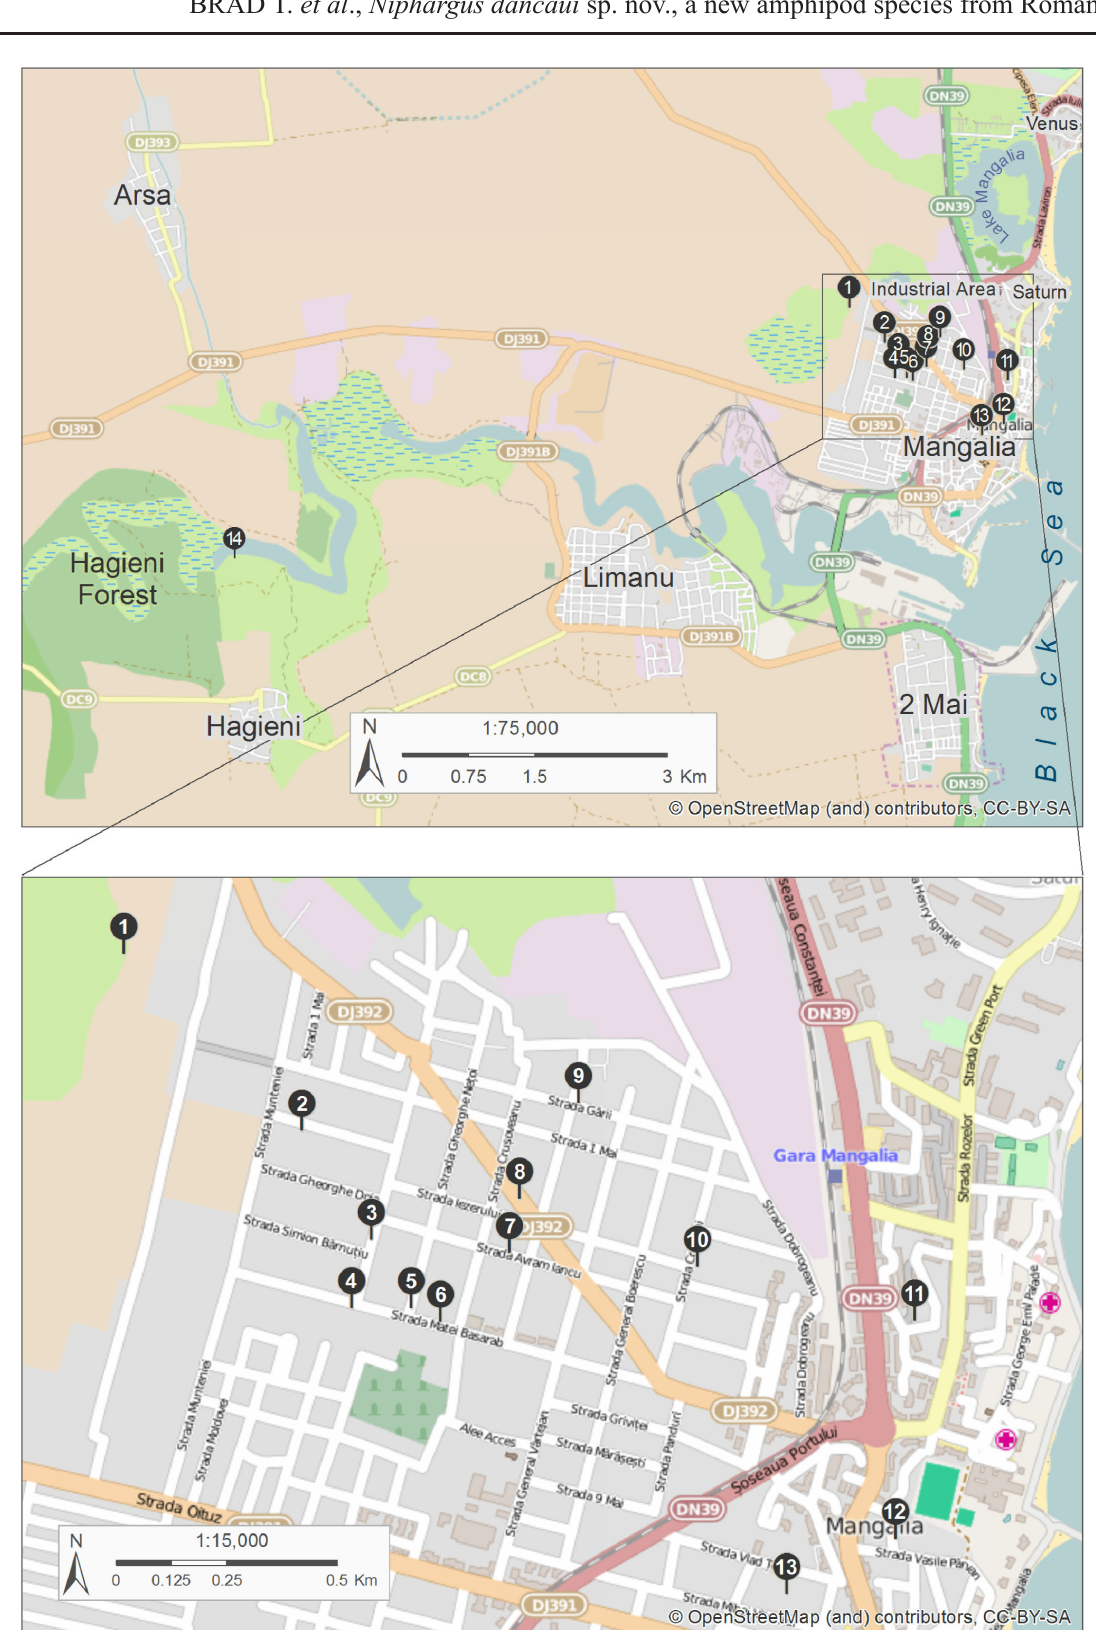
Fig. 1. Map of the research area with indication of sampling